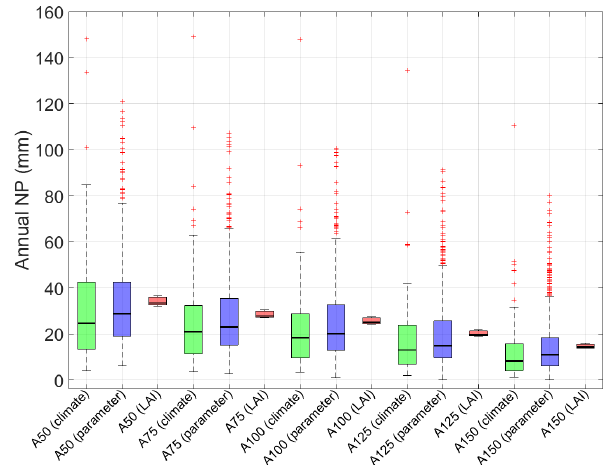
Figure 12. Box plots showing the distributions of annual NP ob- tained from the simulated water balances for the five illustrative covers with 700 parameter sets (blue boxes show parameter vari- ability) over a 60-year climate cycle (green boxes show climate vari- ability) with four LAI values (red boxes show LAI variability). The description of the box plots is the same as for Fig.